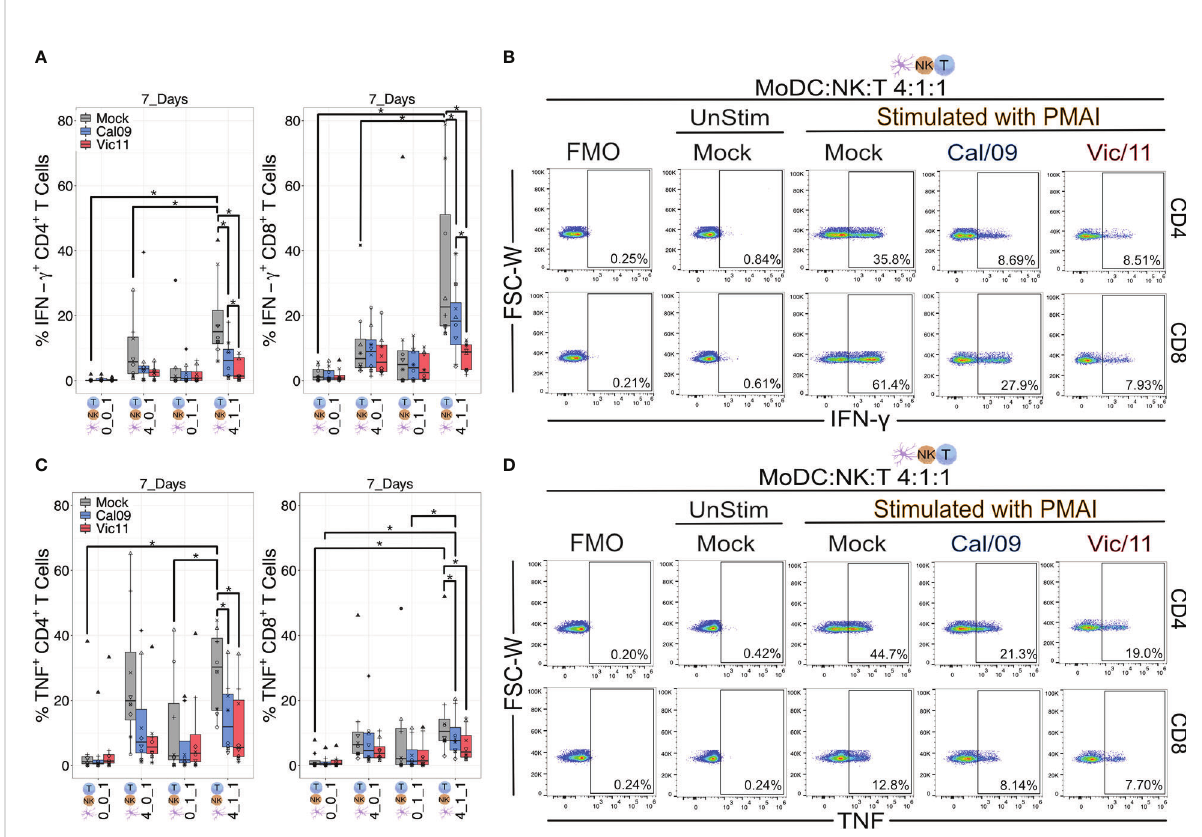
FIGURE 8 IAV-exposed MoDCs in co-culture with NK cells suppress the production of IFN- g and TNF from CD4 + and CD8 + T cells. Summary plots of CD4 + and CD8 + T cell IFN- g + (A) or (C) TNF + expression after culture with mock-treated or Cal/09- or Vic/11-exposed MoDCs (MOI = 3) after 7-day co-culture with MoDCs and NK cells at a MoDC to NK cell to T cell ratio of 0:0:1, 4:0:1, 0:1:1 or 4:1:1 followed by stimulation with PMA/I for 4 h and assessed by intracellular cytokine staining and fl ow cytometry using an antibody speci fi c to IFN- g or TNF ( n = 7). Representative fl ow plots of the frequency of IFN- g + (B) or (D) TNF + CD4 + T cells (top) and CD8 + T cells (bottom) after 7-day co-culture with Cal/09- or Vic/11- exposed MoDCs (MOI = 3) at a MoDC to NK cell to T cell ratio of 4:1:1 followed by stimulation with PMA/I for 4 h and assessed by fl ow cytometry using an antibody speci fi c to IFN- g or TNF. The same shape between conditions indicates that the data point is derived from the same donor. * p < 0.05, Wilcoxon signed-rank